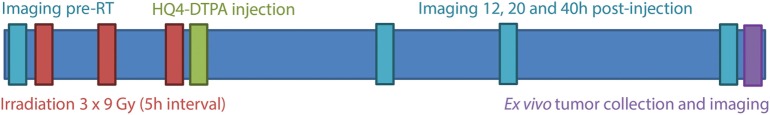
Experimental schedule. Three fractions of 9 Gy irradiation were delivered with a 5-h interval and HQ4-DTPA was injected at the end of the irradiation schedule. In vivo photoacoustic and fluorescence imaging were performed at 12, 20, and 40 h following the injection.